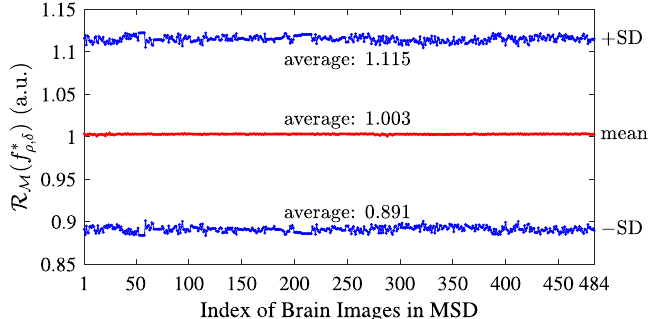
Figure 4. The mean (red) and mean ± SD (blue) of the local mass-measure stretch ratio of the TSOMT maps 8 for each of the 484 brain images in the MSD Challenge dataset, as well as the averages of the means with p = and ± SDs over the 484 images.